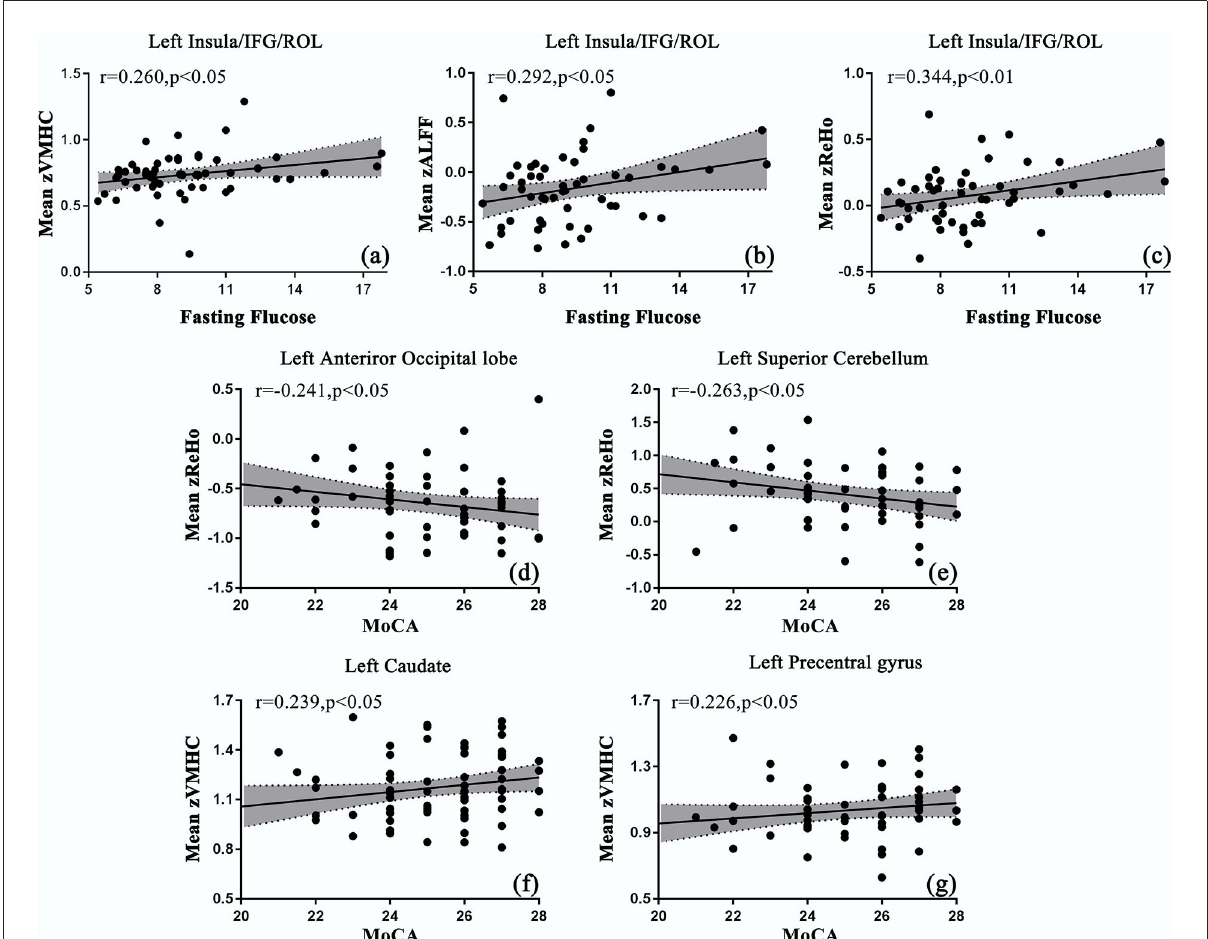
FIGURE2 Correlations between the mean values of resting-state functional magnetic resonance imaging (rs-fMRI) indices and clinical parameters in patients with T2DM. (a–c) The mean values of ALFF/ReHo/VMHC were positively correlated with fasting glucose in s INS/IFG/ROL.L; (d, e) the mean values of ReHo were negatively correlated with Montreal Cognitive Assessment (MoCA) scores in the left occipital lobe and cerebellum; (f, g) the mean values of VMHC were positively correlated with the MoCA scores in CAU.L and